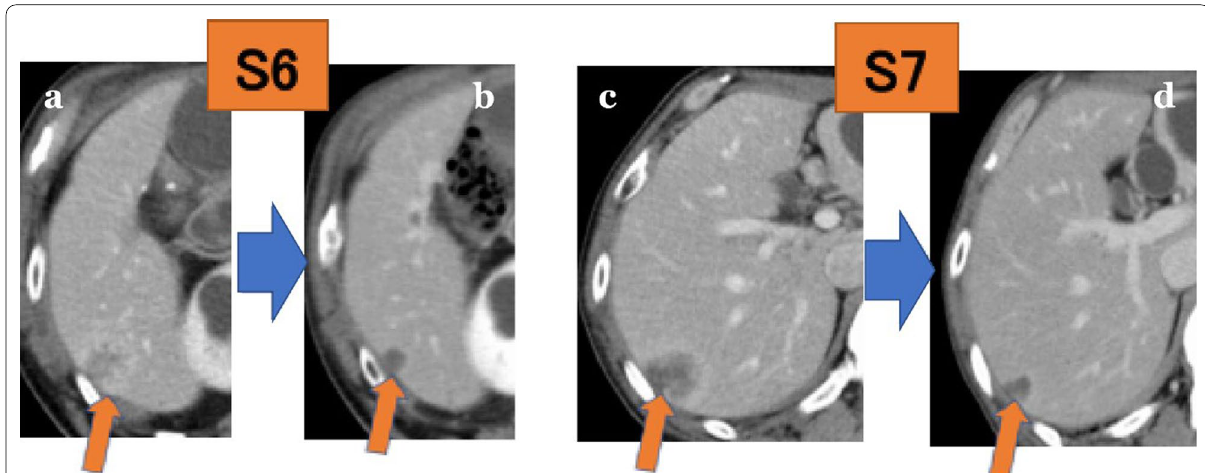
Fig. 1 Computed tomography images before and after lenvatinib plus pembrolizumab treatment. (orange arrow) a Metastatic tumor in segment 6 before treatment. b Metastatic tumor in segment 6 after treatment. c Metastatic tumor in segment 7 before treatment. d Metastatic tumor in segment 7 after treatment